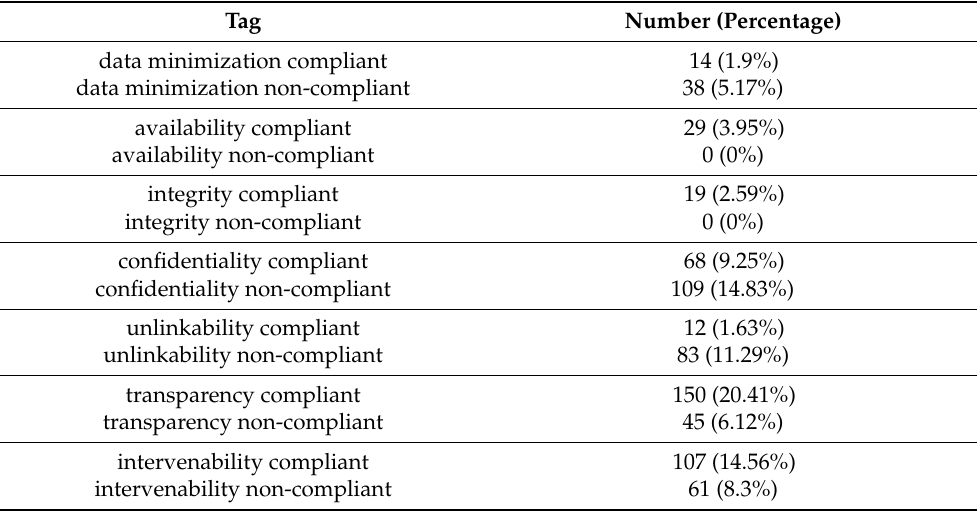
Table 1. Distribution of tags in the training data